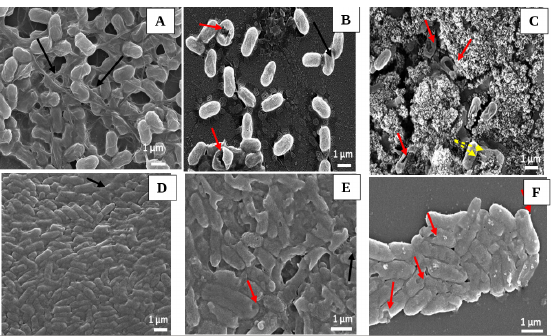
Figure 11: Scanning electron micrograph of B. cereus and P. aeruginosa biofilms before and after DC and TiO 2 -NP exposure. (A) control biofilm of B. cereus , (B) DC-treated B. cereus biofilm, (C) TiO 2 –NPs- treated B. cereus biofilm, (D) control biofilm of P. aeruginosa , (E) DC-treated P. aeruginosa biofilm, (F) TiO 2 –NPs-treated P. aeruginosa biofilm. (Black ar- rows indicate EPS matrix, red arrows, furrows in dam- aged cells and yellow dashed arrows ,